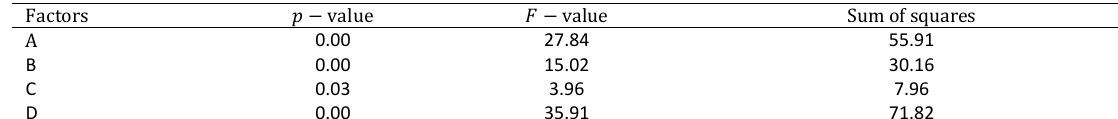
Table 3: ANOVA analysis for the phenol biodegradation by strain O-CH1